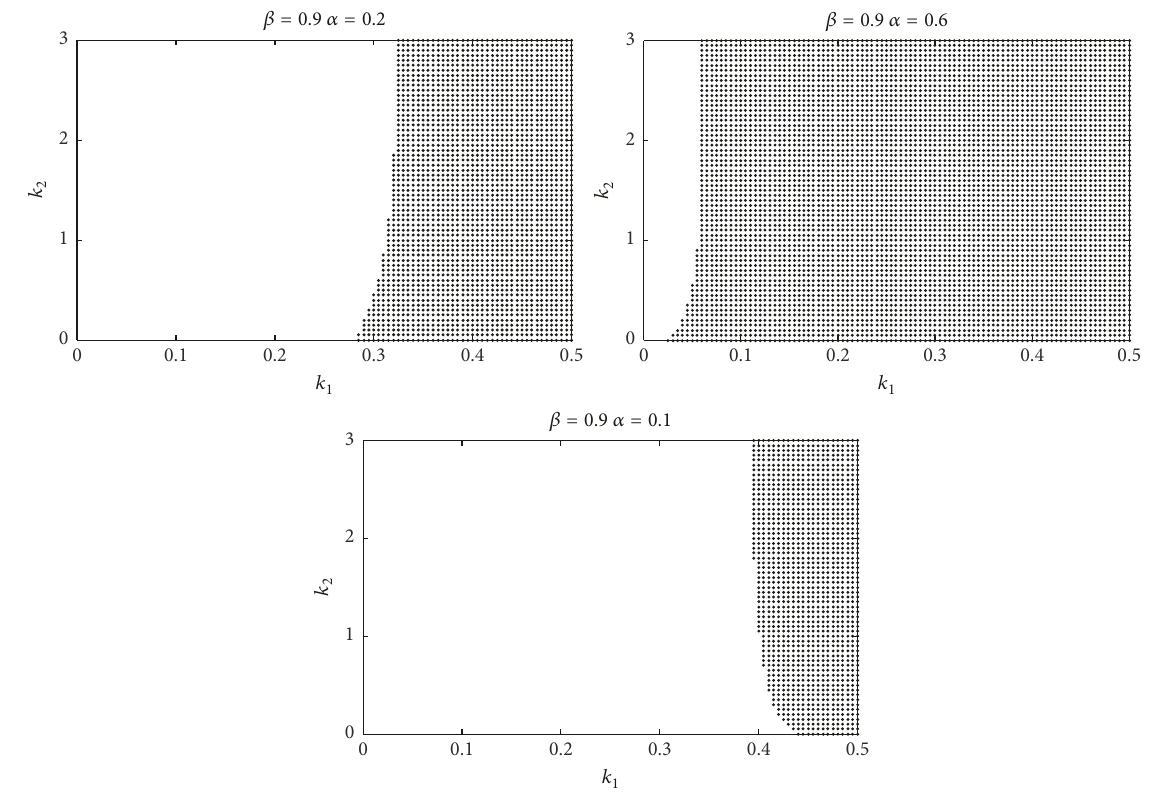
Figure 8: Stability regions in the (𝑘 1 ,𝑘 2 ) -plane for different levels of 𝛼